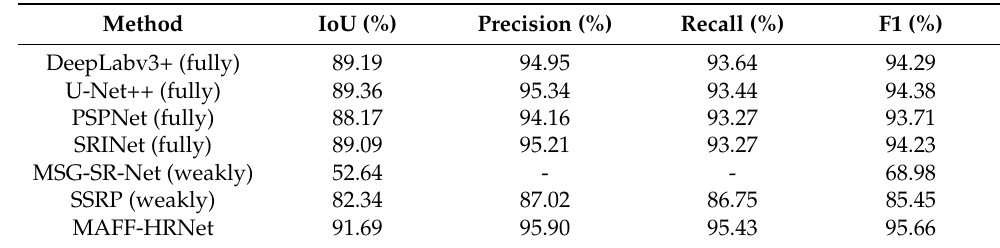
Table 2. Evaluation results on the WHU Building Dataset. The symbol “-” means that a corresponding result is not given for this method in its associated paper.